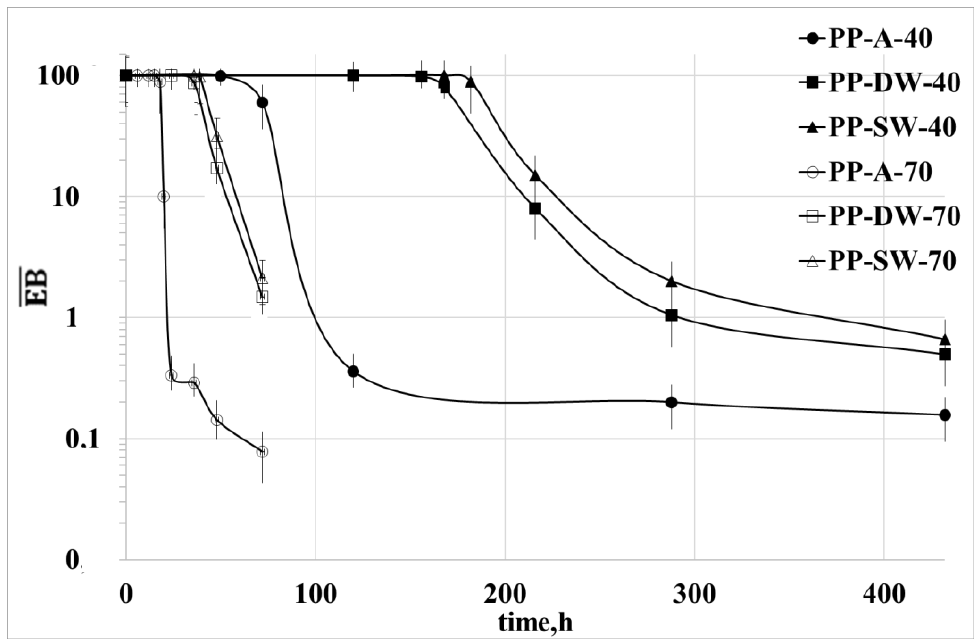
Figure 8. Dimensionless elongation at break as a function of the irradiation time for all the samples at the two temperatures.